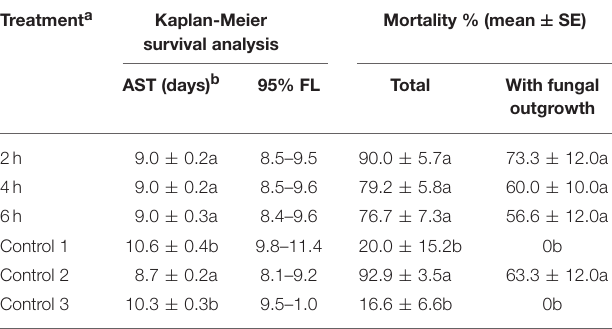
TABLE 3 | Effect of the exposure time to UV-B (1200 mWm − 2 ) on the virulence of M. brunneum strain against adult B. oleae . Treatment a